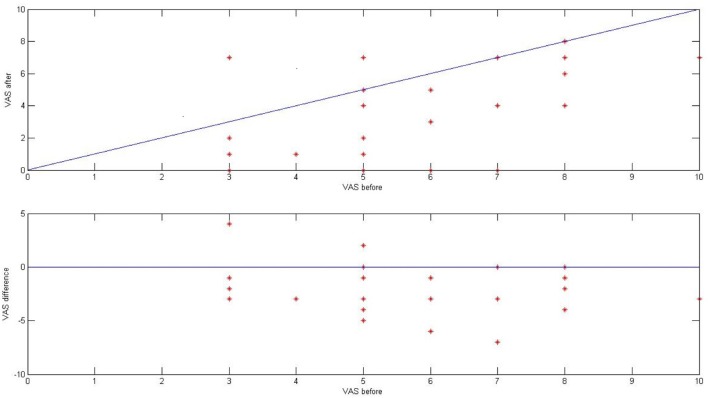
The effect of ES on tinnitus in the tinnitus group presented as a result in VAS for tinnitus loudness (before and after stimulation).